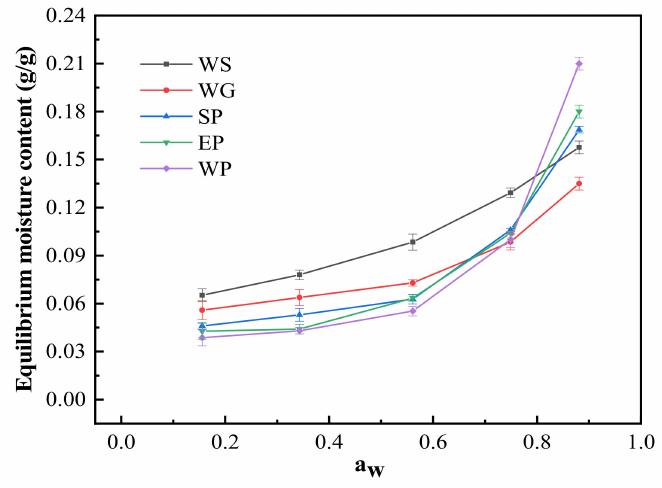
Figure 1. Moisture adsorption isotherms for wheat starch and four proteins. WS, WG, SP, EP, and WP represent wheat starch, wheat gluten, soy protein, egg white protein, and whey protein, respectively.